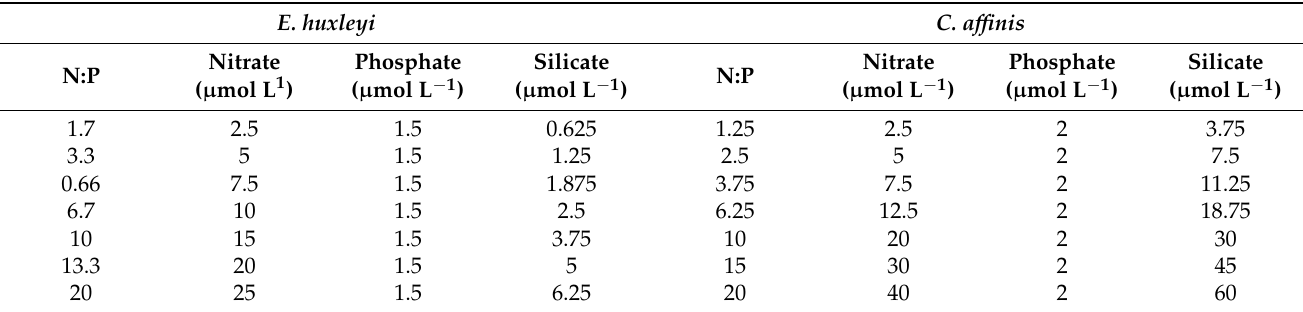
Table 1. Nutrient levels applied to measure uptake rates V at different concentrations of nitrogen for each genotype of E. huxleyi and C. affinis